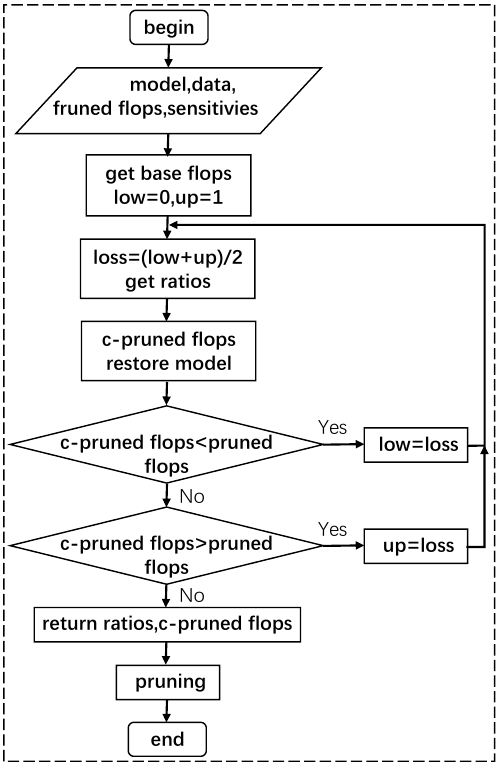
Figure 3. Pruning algorithm flow based on sensitivity